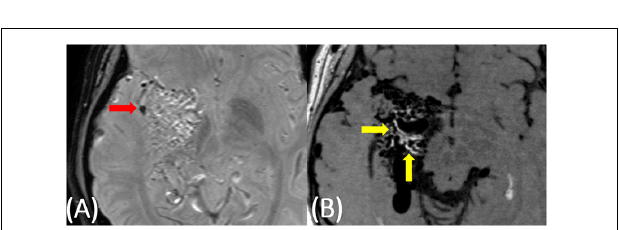
FIGURE 3 | 20-year-old female with a right temporoparietal AVM with a small area of sub-clinical evidence of prior hemorrhage on susceptibility-weighted imaging ( A , red arrow). On post-contrast VW-MRI (B) , there were multiple areas of hyperintensity at the vessel wall (yellow